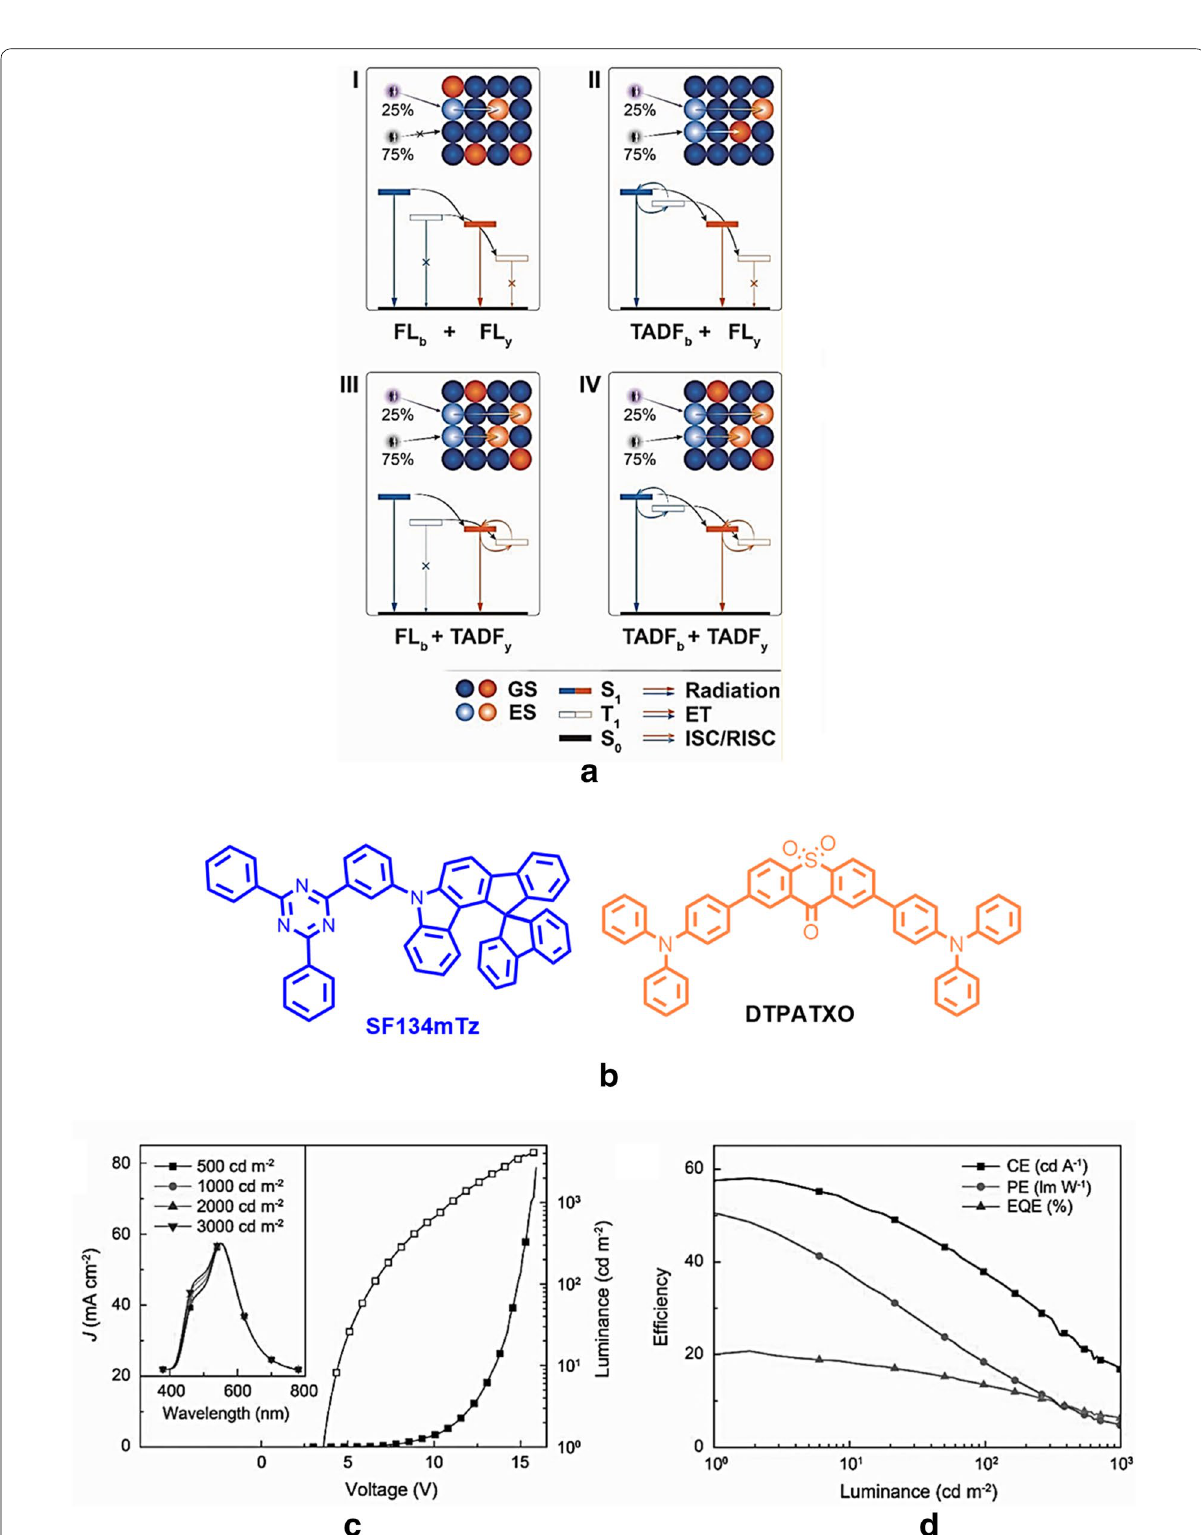
Fig. 20 a Strategies for white light generation from the device. GS, ES, and ET, ground state, excited state and energy transfer respectively. b DTPATXO a yellow TADF structure, c luminance and J–V and EL spectra (inset) of the devices, d luminance efficiency curves of the devices (Reproduced with permission from Ref. [51] Copyright 2018, ©WILEY–VCH Verlag GmbH &amp; Co. KGaA,